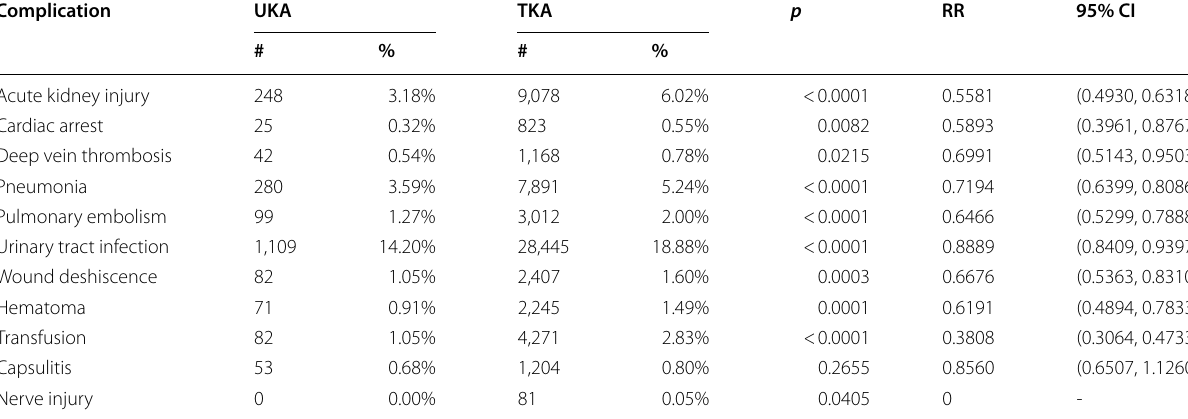
Table 7 Incidence of complications within 12 months following TKA and